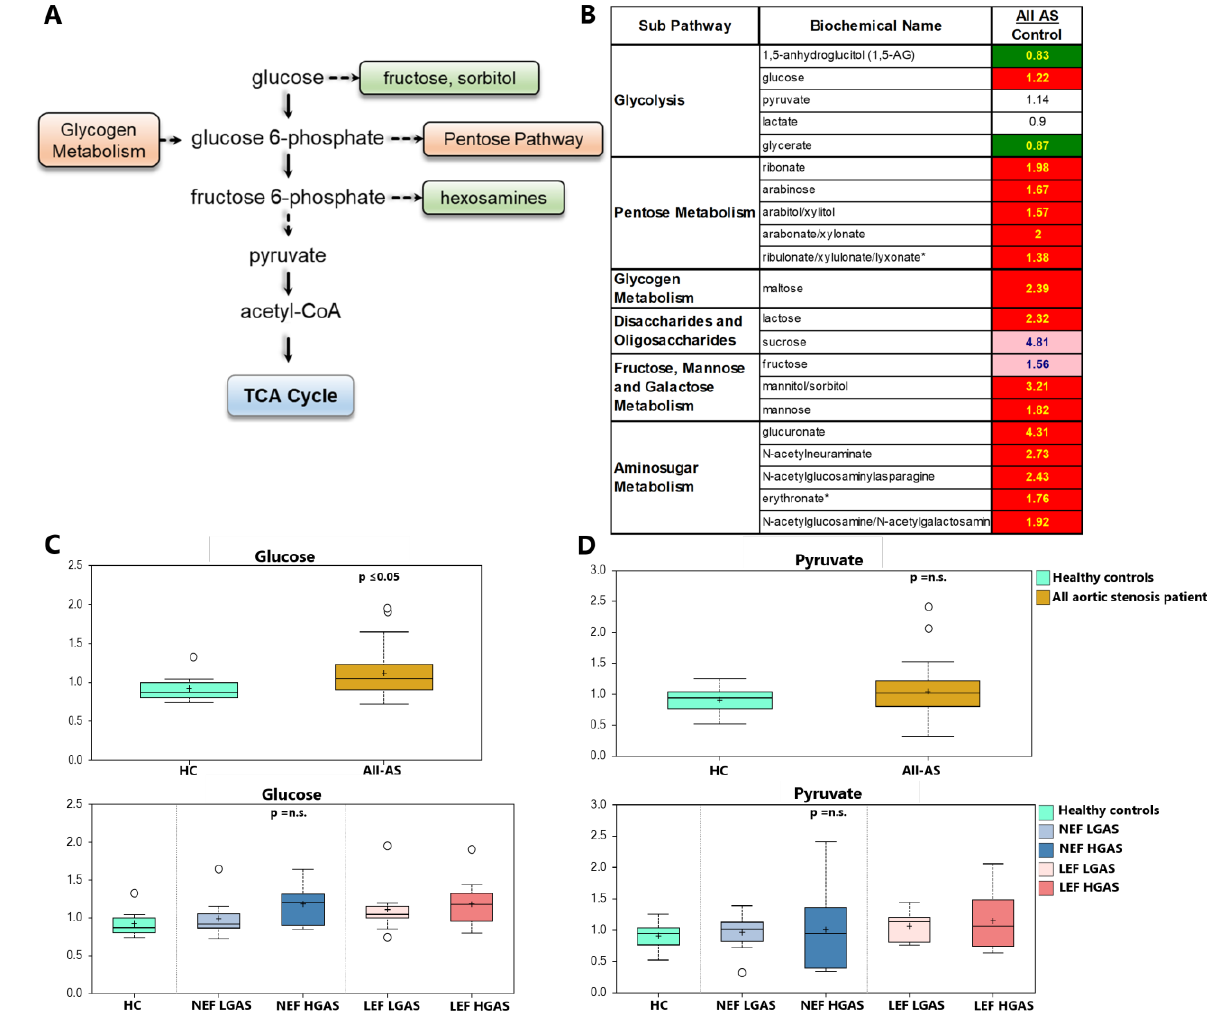
Figure 5. Sugar metabolites in AS and healthy controls. ( A ) Illustration of glucose utilization pathways for energy production via TCA cycle including glycolysis, pentose phosphate pathway (PPP), and hexosamine biosynthetic pathway. ( B ) List of altered metabolites. Significantly up- and downregulated molecules are marked in red and green, respectively. Values marked in light red indicate a trend towards statistical significance (0.05 < p < 0.10). Non-colored values are not significantly different for that comparison. Numbers indicate x-fold increase/decrease in concentration. * p ≤ 0.05. ( C ) Glucose as an example between All-AS vs controls as well as the different AS subgroups. ( D ) Pyruvate as an example between All-AS vs controls as well as the different AS subgroups. On each box, the black cross indicates the mean value, the borders and segmentation indicate limits of upper/lower quartile and median values. Outliers are plotted as circles. n.s.: not significant between AS subgroups.